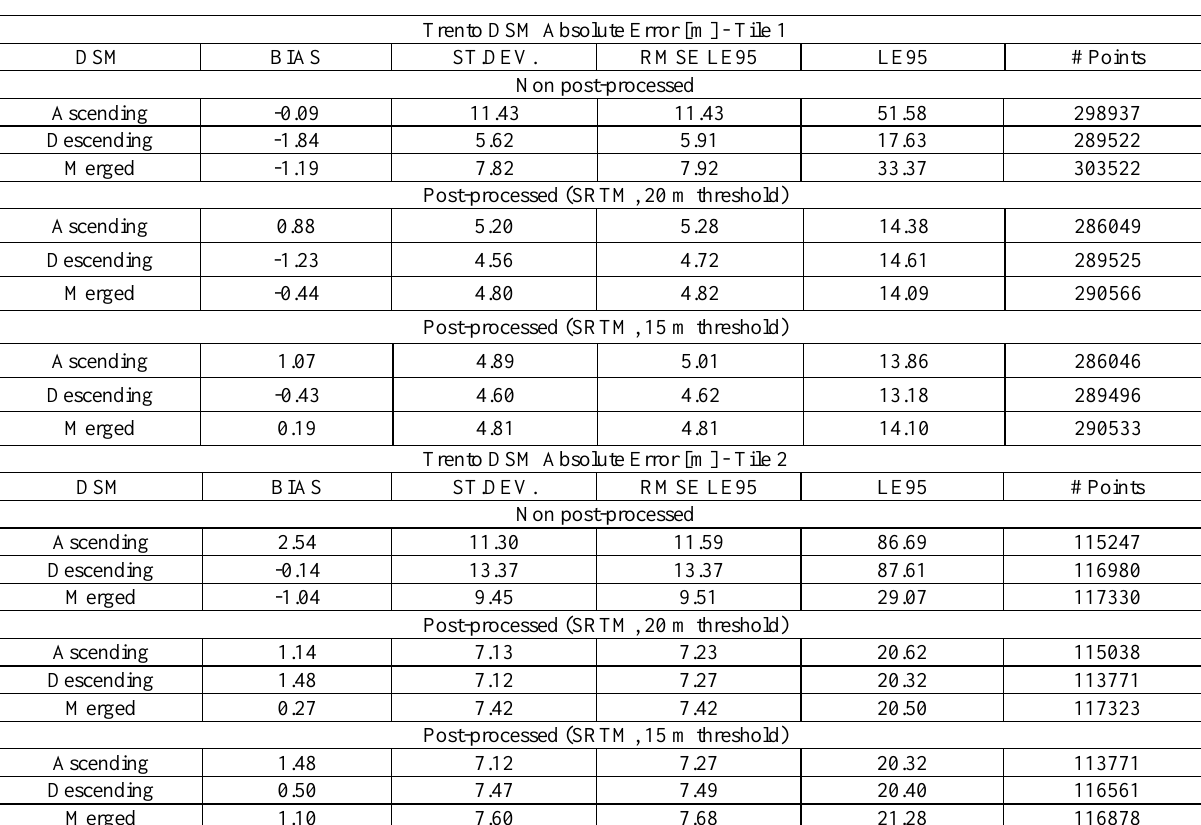
Table 3. Trento interpolated DSMs analysis